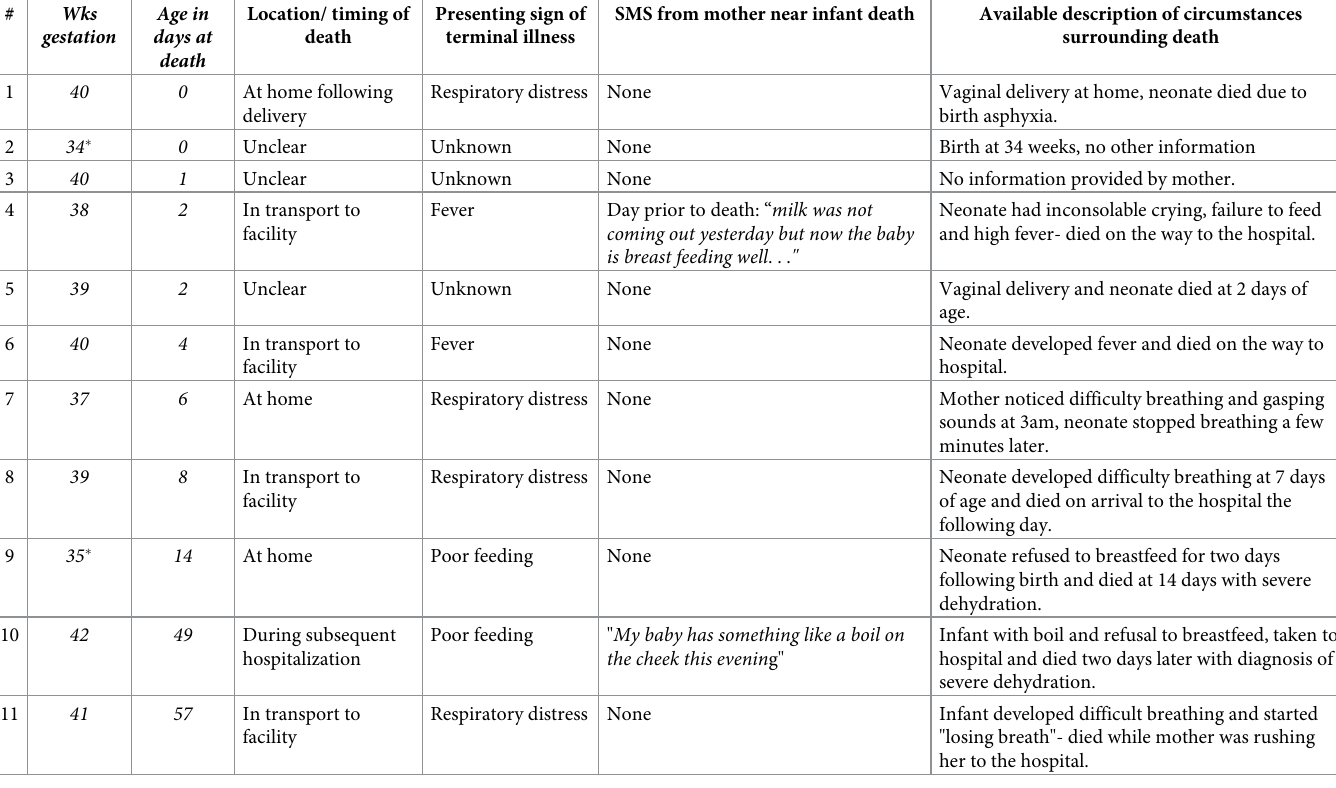
Table 6. Description of circumstances and SMS interactions for mothers whose infant died after time at